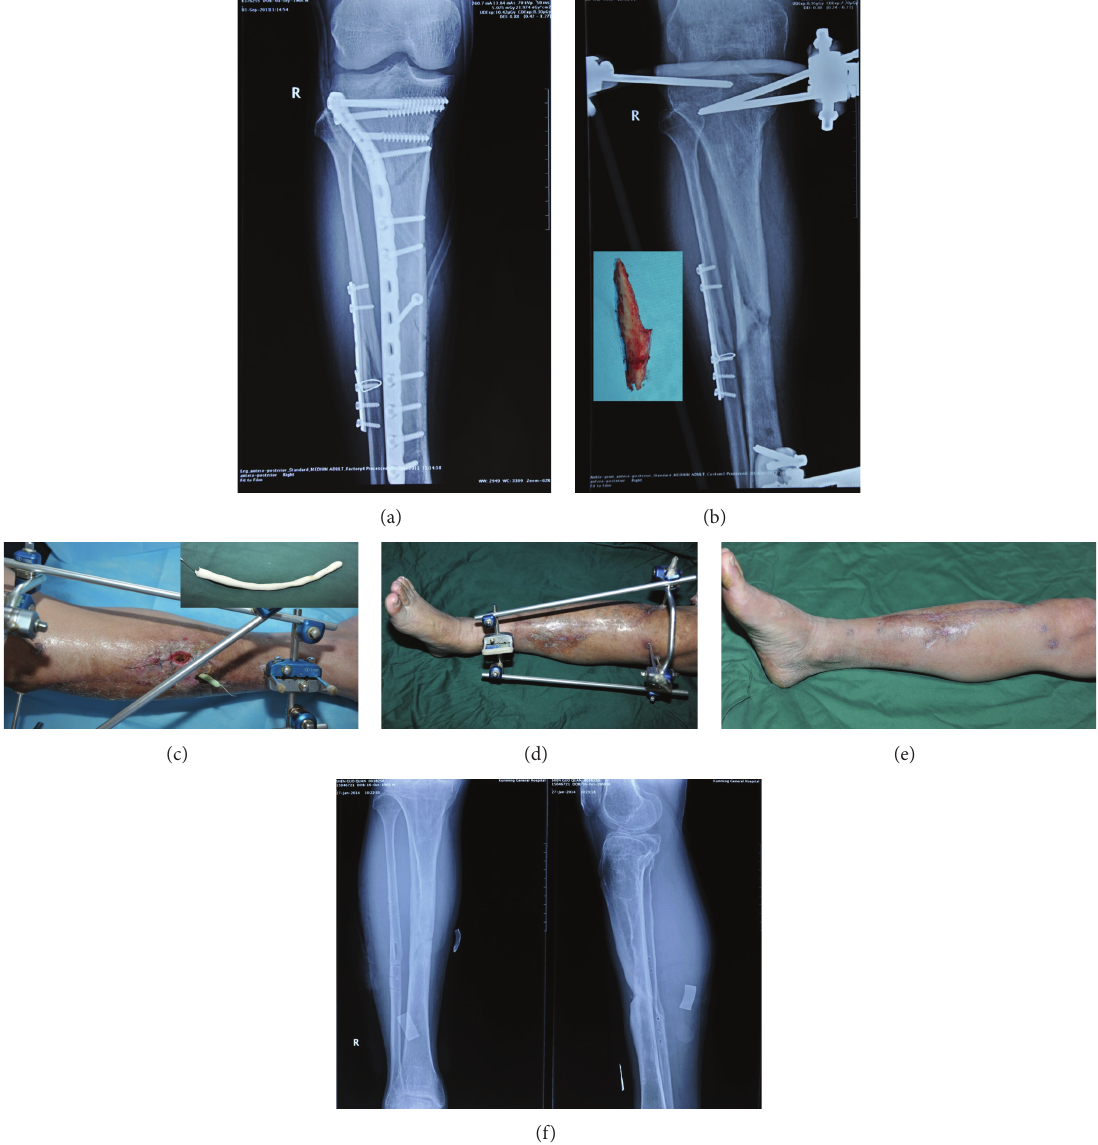
Figure 1: A patient sustained a Gustilo III A fracture in the tibia and received a plate-and-screw fixation. Two weeks later, there was infection on the wound. After debridement, persisting irrigation, and temporary reservation of the hardware for another two weeks, there were no signs of healing (a). The plate of the tibia was removed and replaced by assembled external fixators. A dead bone could be seen on the X-film and was later removed (b). After sufficient debridement, a custom-made vancomycin cement rod wias was inserted into the sinuses and the intramedullary cavity (c). Six months after the surgery, the sinuses and the osteomyelitis healed (d). Eighteen months after our surgery, both the wound and the bone healed uneventfully ((e),